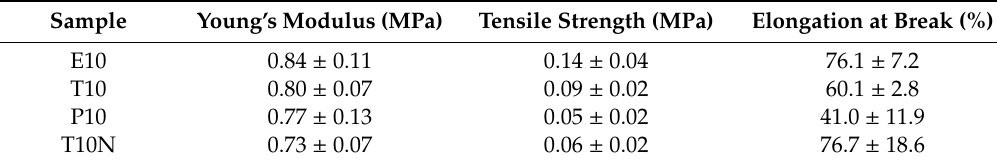
Table 1. Mechanical properties of PAMPS membranes.